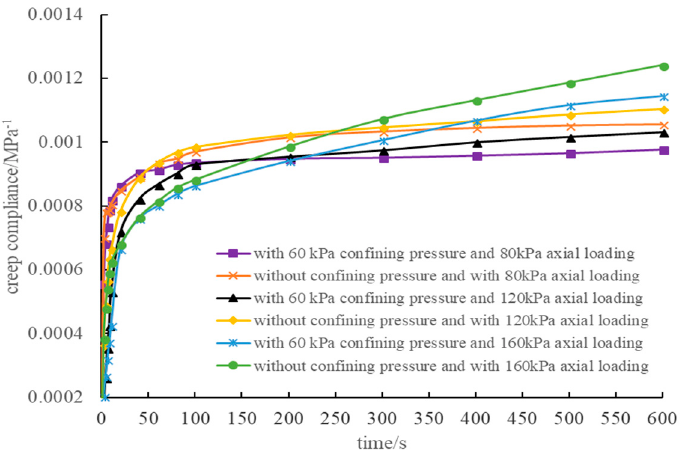
Figure 13. Experimental creep compliance curves under different loading conditions.